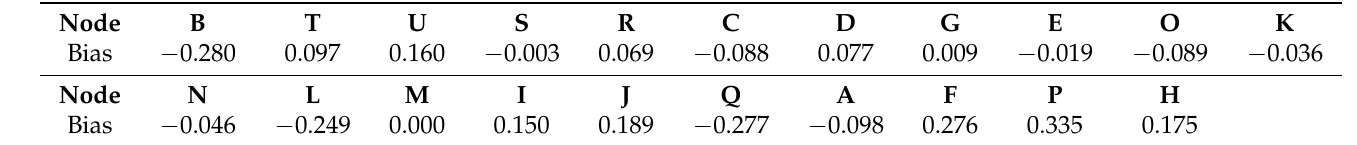
Table 1. Temperature bias ( ◦ C) per node derived from the calibration